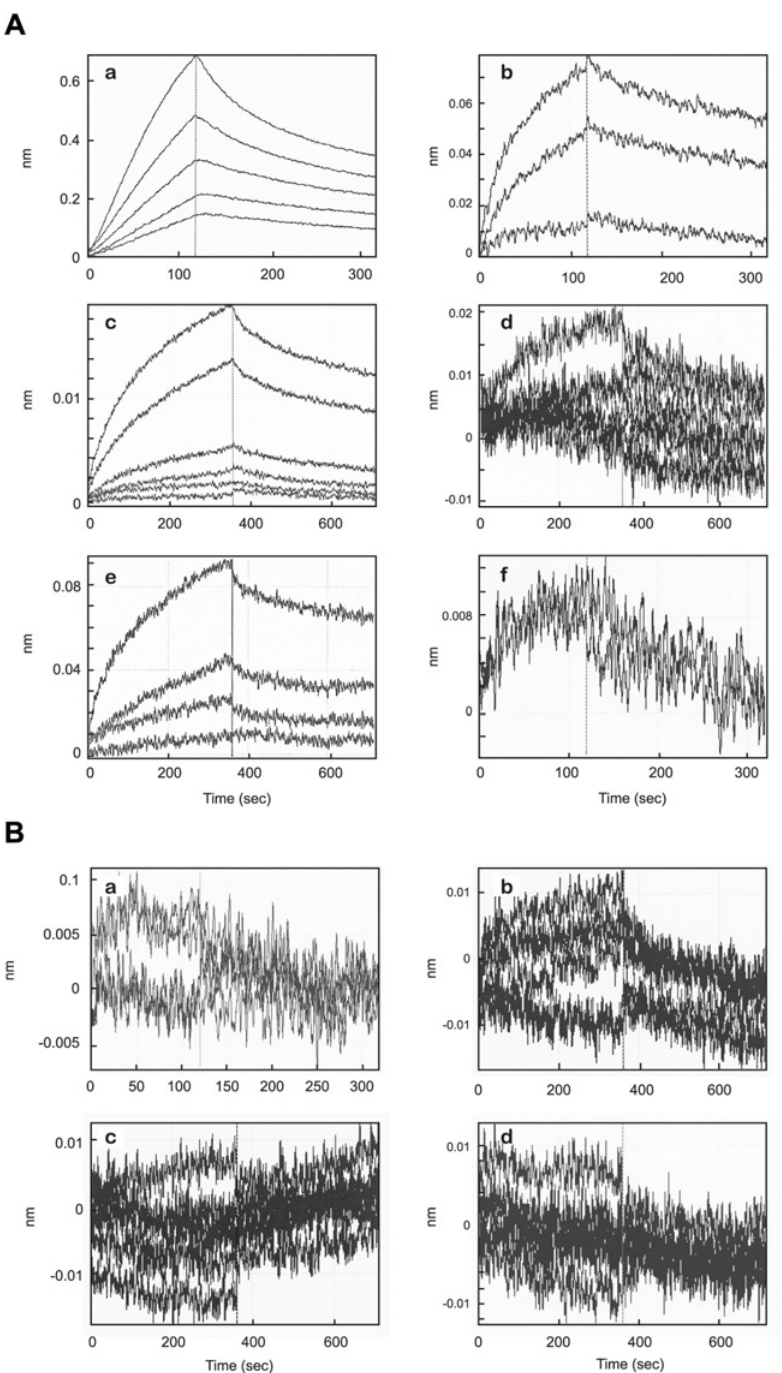
Fig 5. Global Kinetic Analysis Of Purified Soluble APP (A) Or Control IgG (B) Binding To Biotinylated Peptides By Biolayer Interferometry. A. Biolayer interferometry analysis of peptides with APPs. Biotinylated peptides were immobilized on SA biosensors and affinity constants (K D , k on , and k off ) for APPs were determined in KB at 30°C. Binding curves showing association and dissociation to various concentrations of APPs of: P8 (a), P1 (b), P4 (c), P5 (d), P7 (e) and scrambled P1 (f). The times and concentrations for each sample were optimized experimentally. Each data set was fit globally with a 1:1 binding model. B. Biolayer interferometry analysis of peptides with control IgG. Biotinylated peptides were immobilized on SA biosensors. The affinity constants (K D , k on , and k off ) for control IgG were determined in